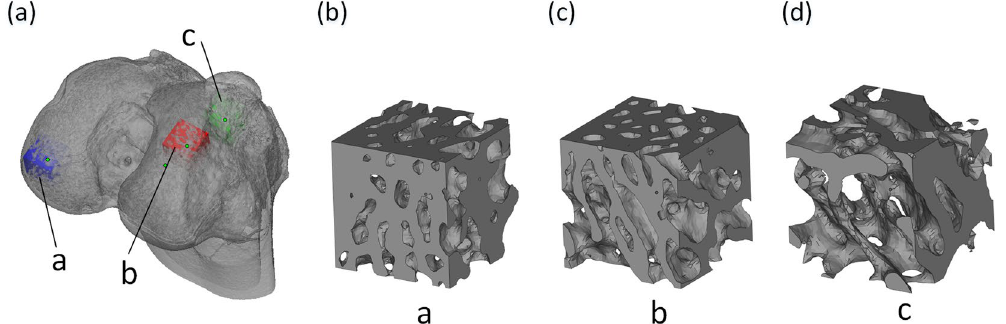
Figure 2. Morphological characteristics of bone units in different regions, ( a ) femoral condyle bone model, ( b ) top region of the femoral condyle bone, ( c ) side region of the femoral condyle bone, ( d ) inner region of the femoral condyle